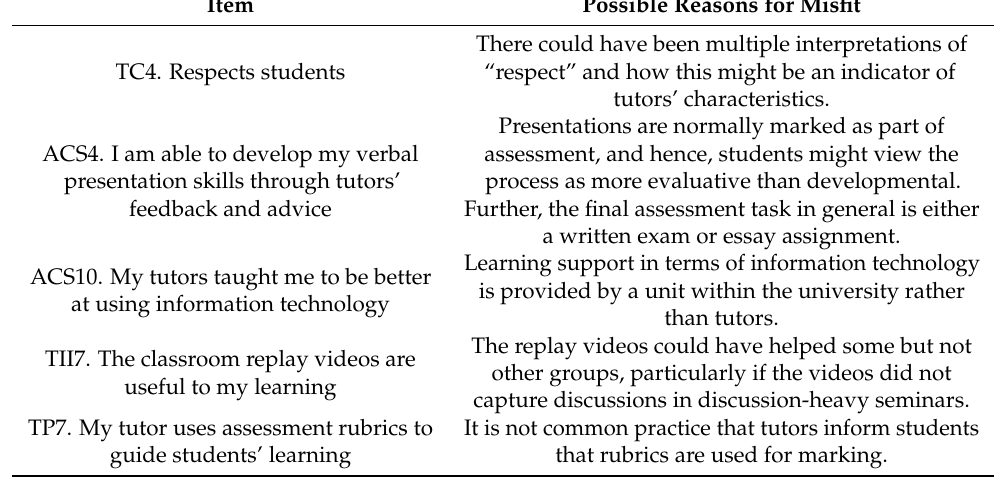
Table 5. Items that contributed to model misfit.